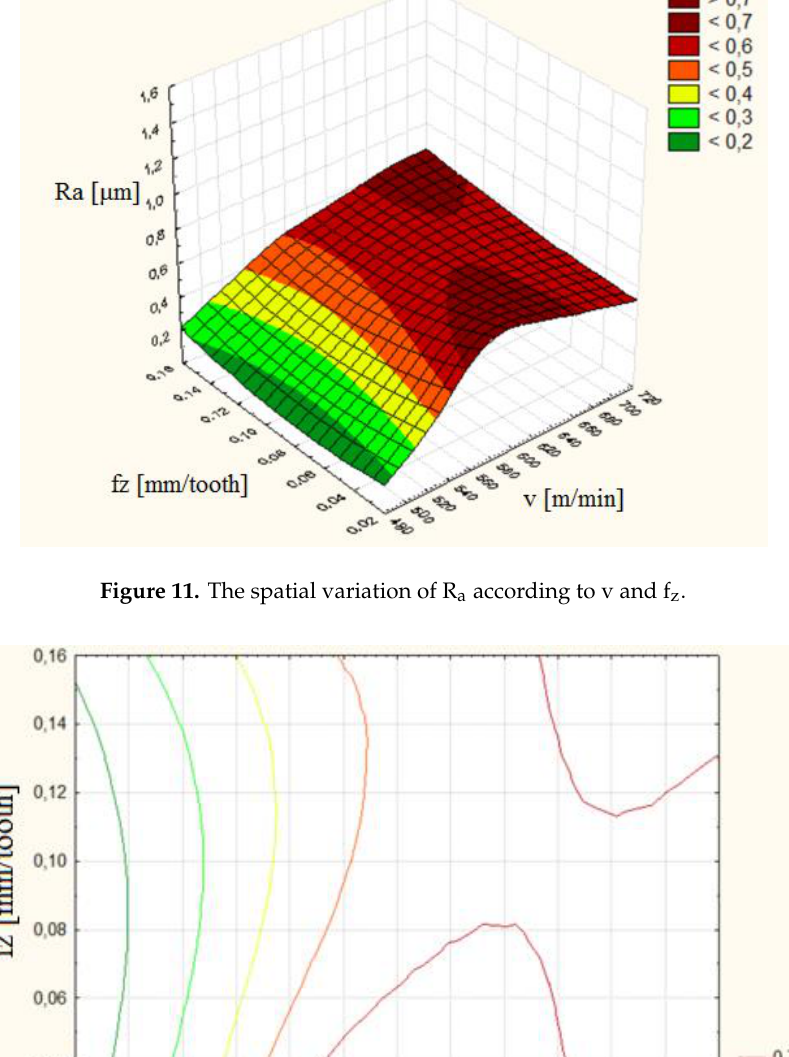
a according to v and f z